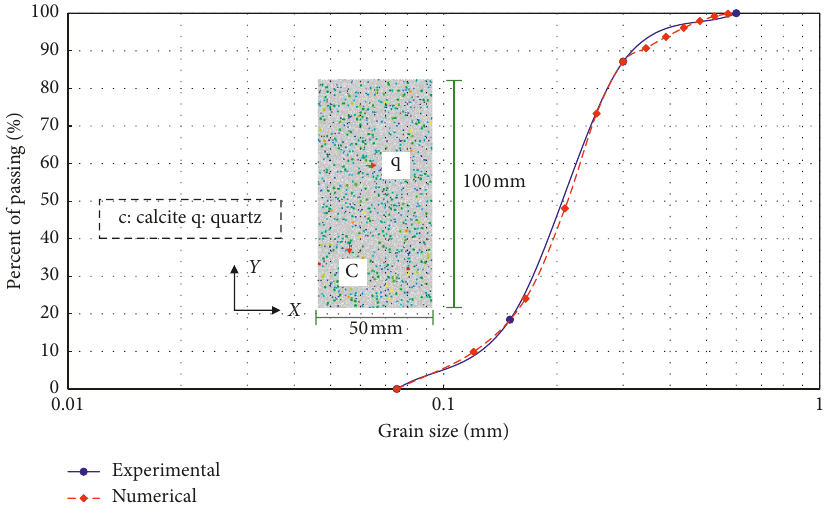
Figure 8: Grain-size distribution of experimental and numerical particles.